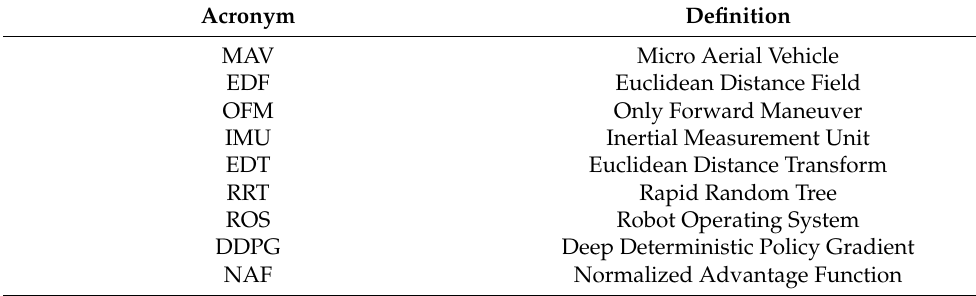
Table 1. The definitions of acronyms used in this